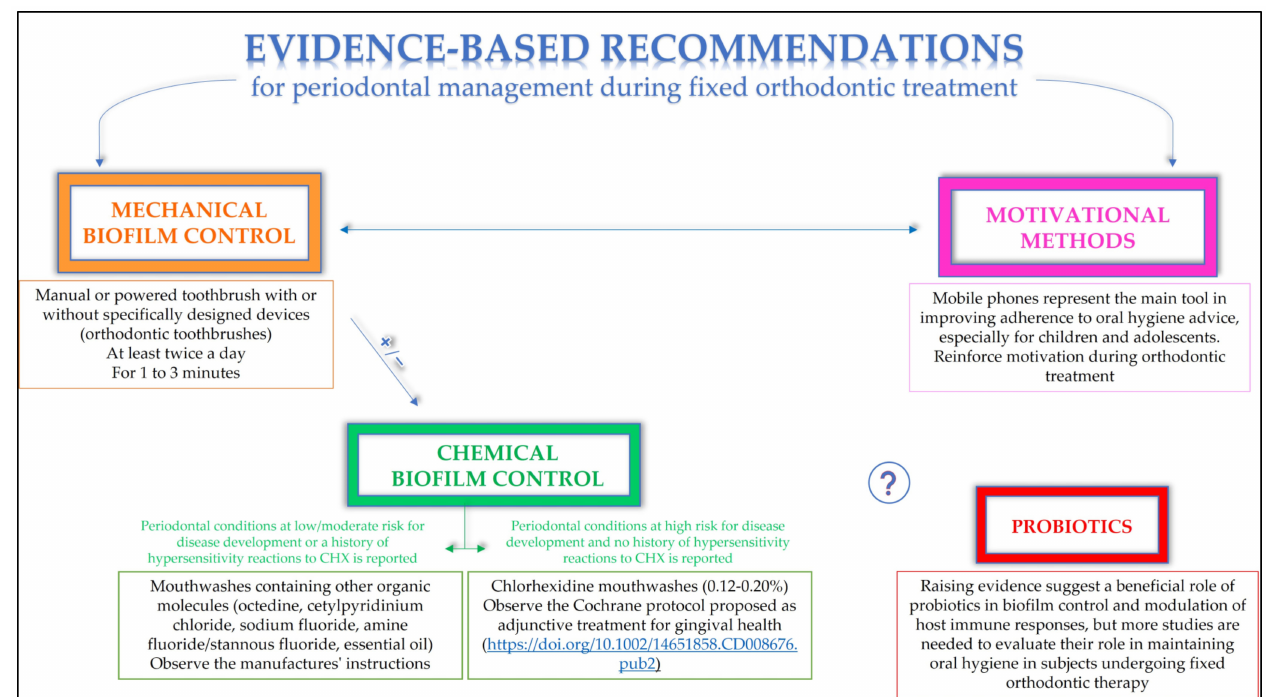
Figure 3. Evidence-based recommendations for periodontal management in periodontally healthy orthodontic patients with fixed appliances